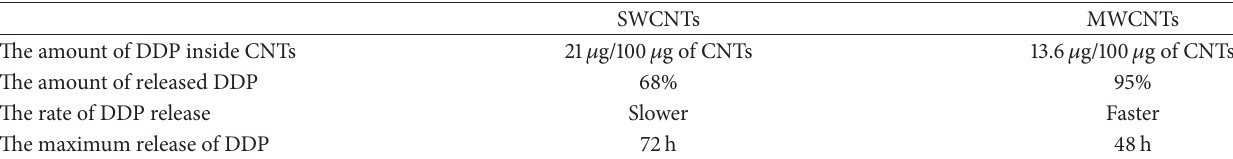
Table 2: Effectiveness of DDP delivery by SWCNTs [134] and MWCNTs [135].